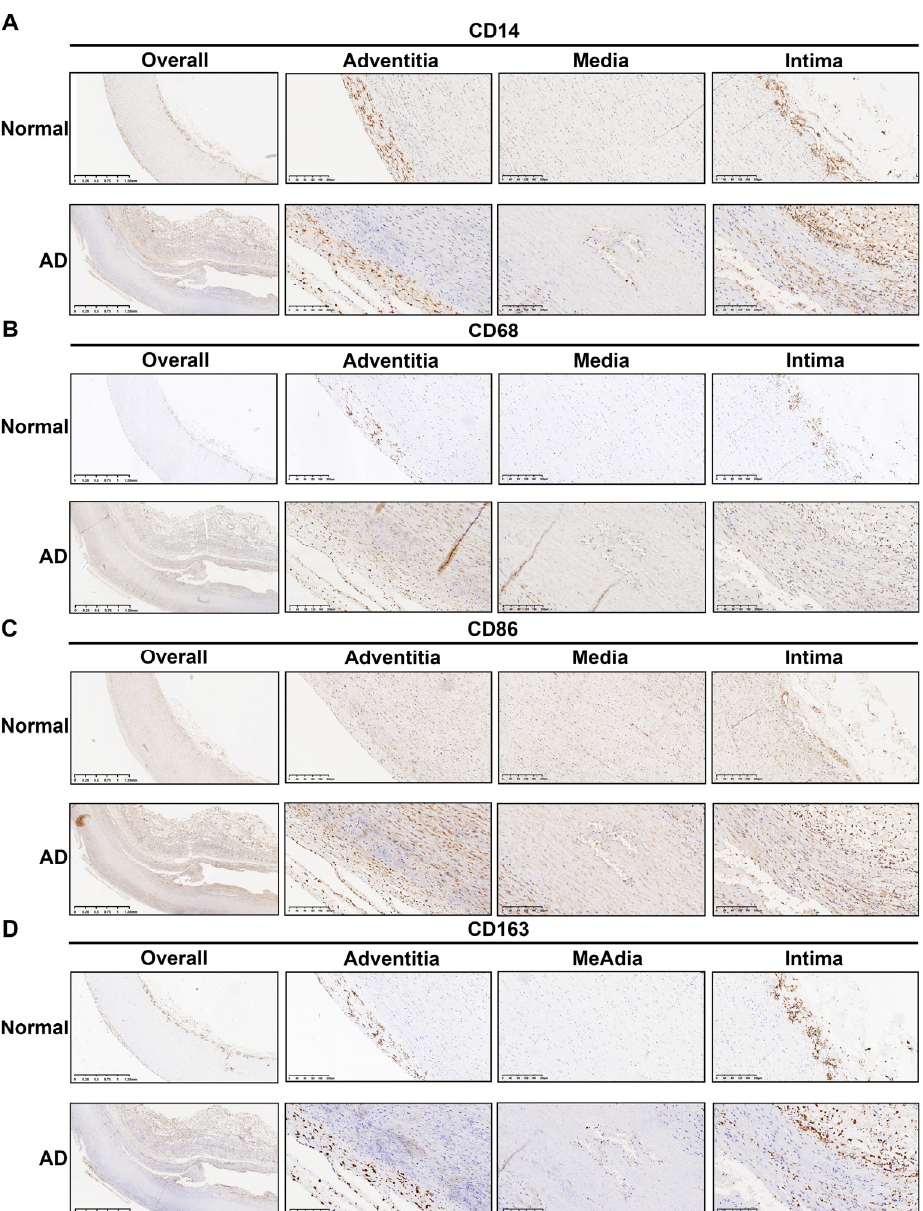
Figure 7. Immunohistochemical analysis of macrophages and monocytes in sections of AD and normal samples. ( A ) CD14 antibody labeling showing the distribution of monocytes in tissues. ( B ) CD68 antibody labeling showing the distribution of macrophages in tissues. ( C ) CD86 antibody labeling showing the distribution of M1 macrophages in tissues. ( D ) CD163 antibody labeling showing the distribution of M2 macrophages in tissues. The image on the left shows an overview of the whole ascending aorta wall tissue (magnification: × 20). The three images on the right show magnifications of the adventitia, media, and intima of the ascending aortic wall, respectively (magnification: ×